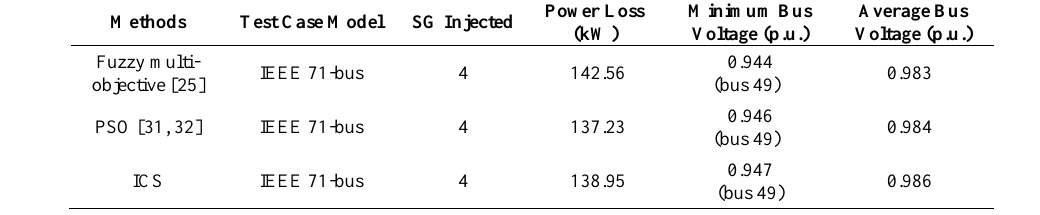
Table 6. Comparison of optimization results of proposed ICS method with fuzzy multi-objective and PSO methods.